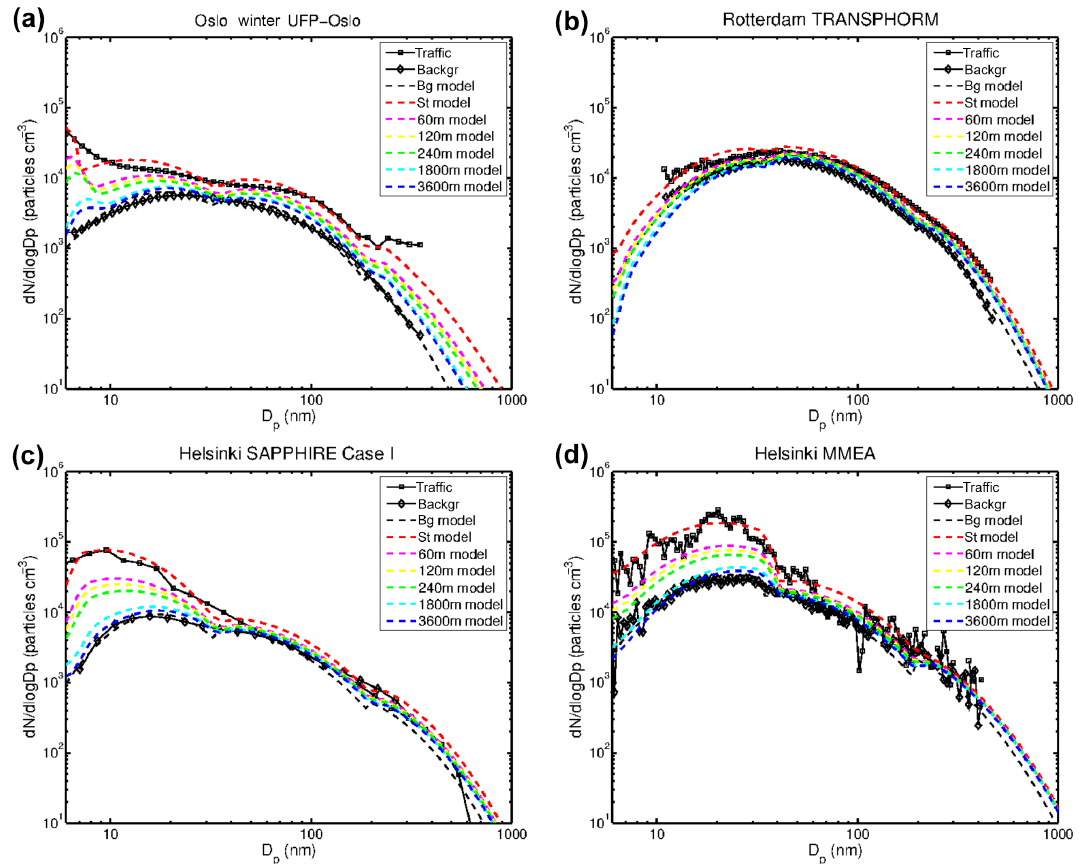
Figure 4. Size distributions (d N/ dlog D p in particlescm − 3 ) downwind of roads in selected campaigns: (a) Oslo, UFP-Oslo Winter, (b) Rot- terdam, (c) Helsinki SAPPHIRE Case I, and (d) Helsinki MMEA. The plots show the measured distribution at roadside (black squares connected by line), the measured distribution at urban background (black diamonds connected by line), the initial model distribution (road- side: dashed red line, background: dashed black line) and the modeled distributions (resulting for moderate dispersion conditions) at distances of 60, 120, 240, 1800, and 3600m, respectively. Size distributions are shown with a lower size cut-off at 6nm.